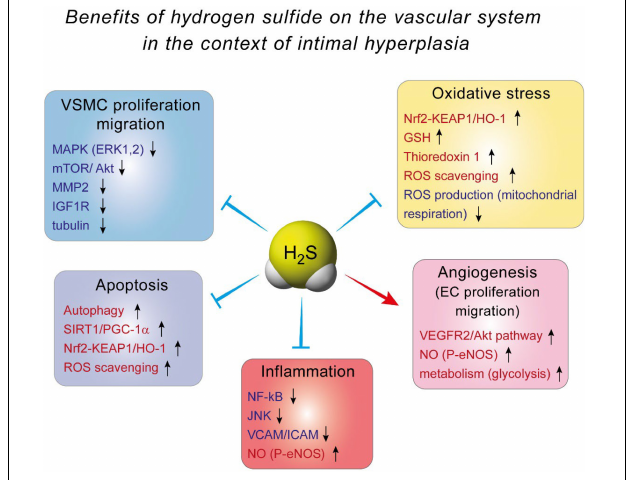
FIGURE 3 | The benefits of hydrogen sulfide on the vascular system in the context of intimal hyperplasia.